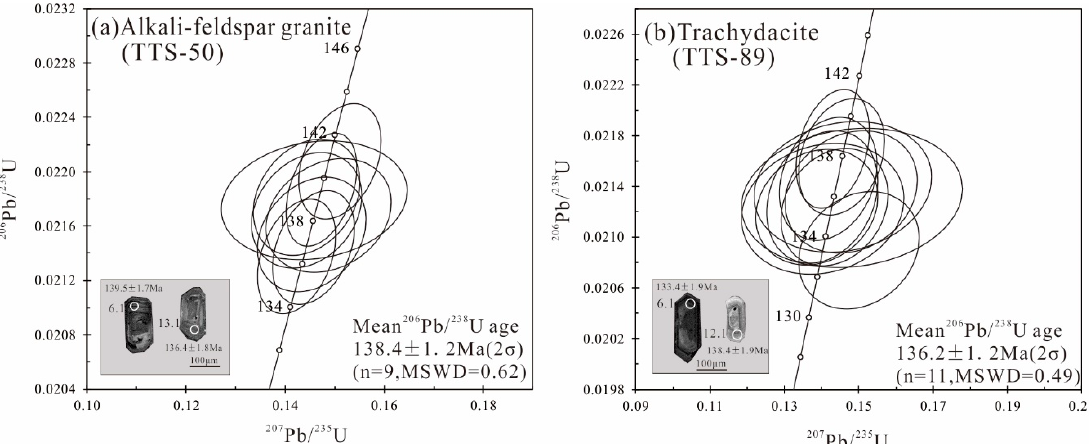
Figure 5. SHRIMP zircon U–Pb concordant curves for the Tiantangshan alkali-feldspar granite ( a ) and trachydacite ( b ).